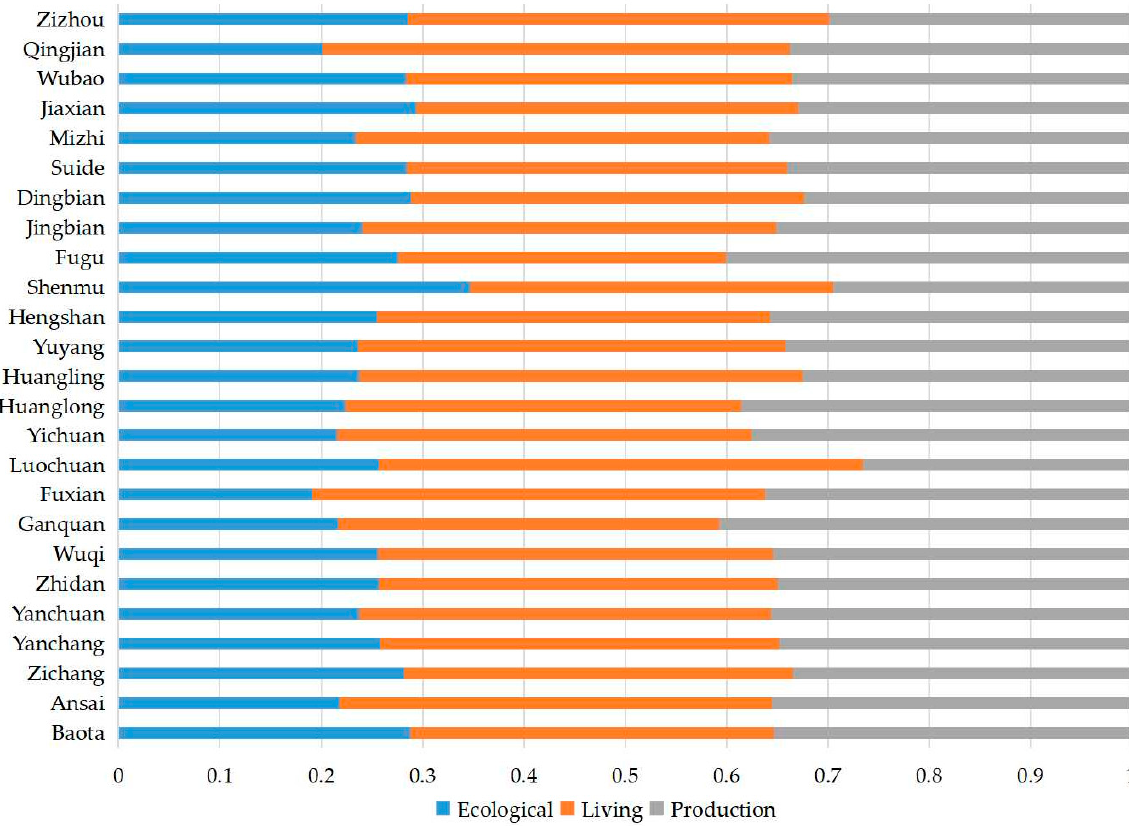
Figure 7. Barrier degrees of production–living–ecological on the enhancement of human settlement environment in northern Shaanxi from 2010 to 2020.